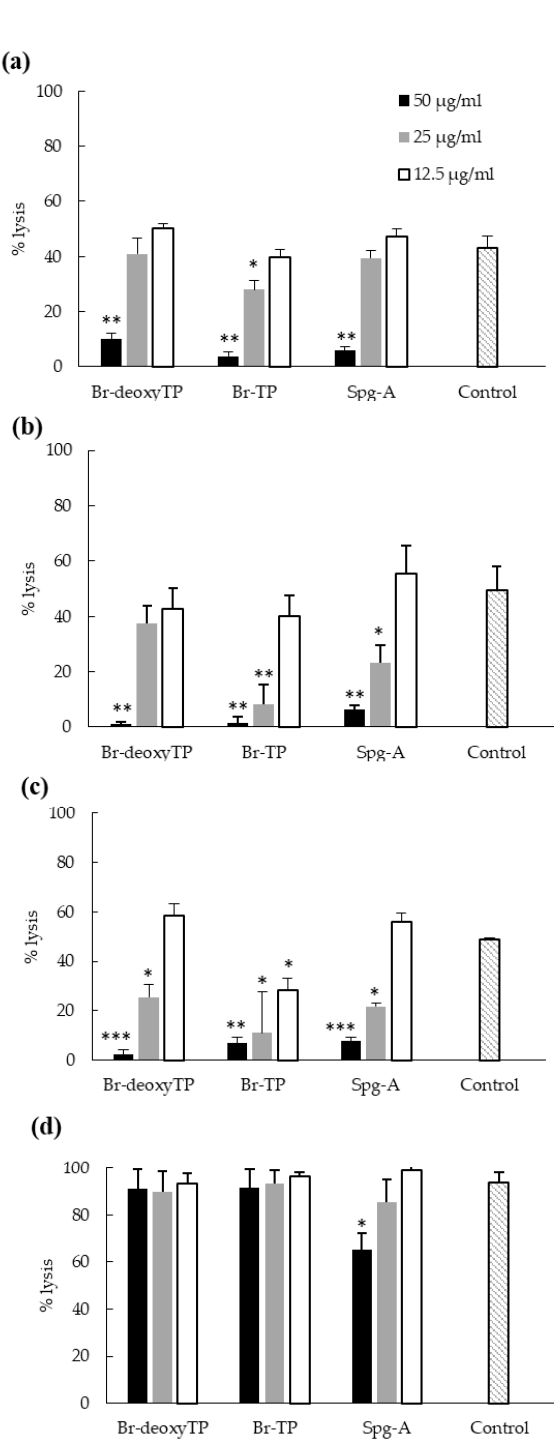
Figure 6. Cytotoxicity inhibition assay carried out with MRSA ( a ), MSSA ( b ), L. monocytogenes ( c ) and V. parahaemolyticus ( d ) after 6 h of incubation of HeLa cells in the presence of Br-deoxyTP, Br-deoxyTP, and Spg-A. HeLa cells were co-incubated with 10 MOI of bacteria in the presence and absence of each compound. After 6 and 24 h, the amount of LDH released (indication of cell lysis) in the supernatant was determined using the LDH assay. Cells with bacteria only were used as the control. The assay was conducted thrice in triplicate. DMSO was used as the negative control and 100% lysis (lysis buffer) as the positive control. (* = p < 0.05; ** = p < 0.01; *** = p < 0.001). p -values were calculated by comparing the samples with 100% lysis control. Error bars represent standard